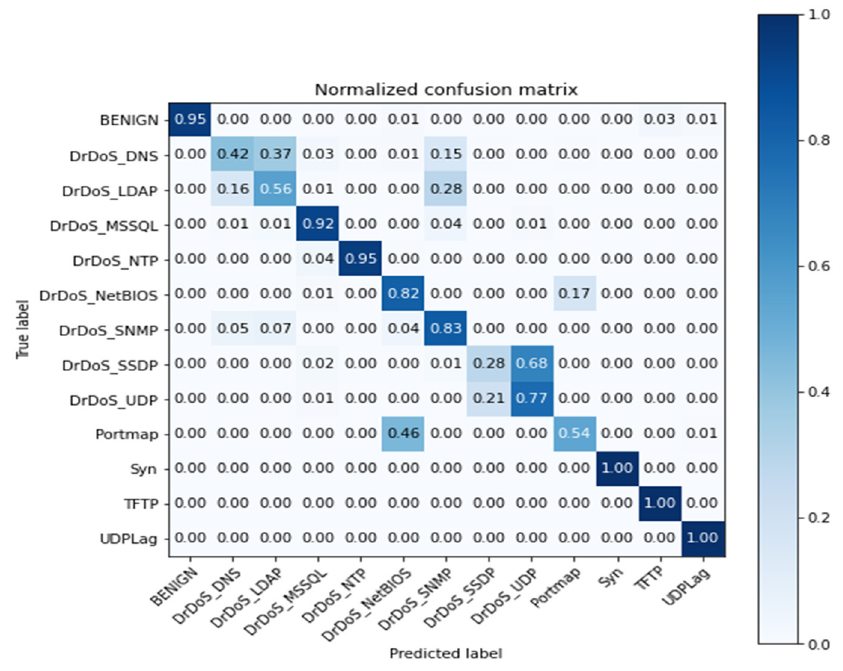
Table 5. Model training results for the first scenario.